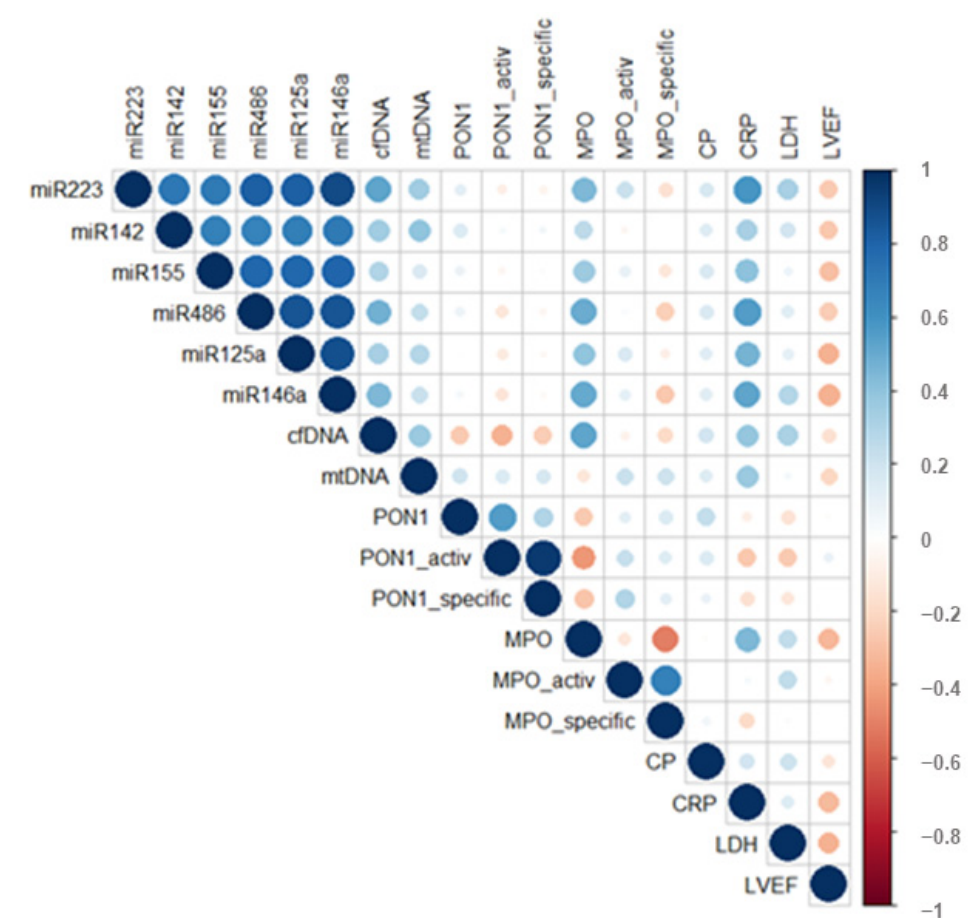
Figure 3. Correlation plots showing bivariate Spearman’s nonparametric correlations between the plasma miRNAs panel and cfDNA levels with patient’s oxidative, inflammatory, and cardiac parameters in ST-segment elevation myocardial infarction (STEMI) patients. Data are illustrated as correlation plots graphs using R-studio software.